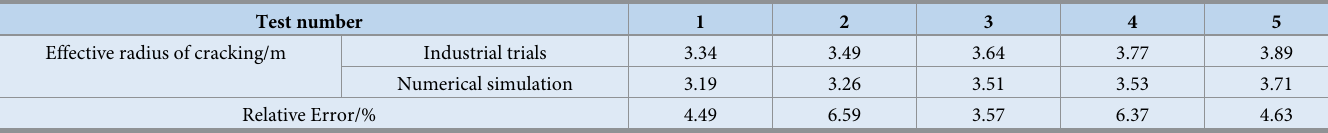
Table 7. Comparison of experimental results and simulation